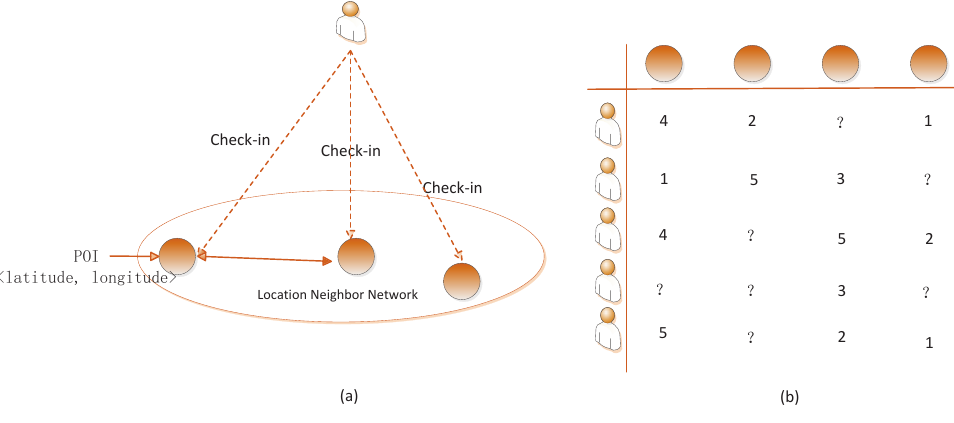
Figure 1. Point-of-interest (POI) recommendation scenario in location-based social networks (LBSNs). ( a ) One typical case of LBSNs. ( b ) The check-in frequency matrix of users to